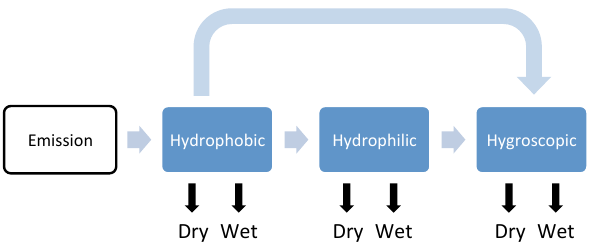
Fig. 1. Diagram showing the 3-ffBC/OM scheme. Hydrophobic, hy- drophilic and hygroscopic BM/OM then enter into the ice nucle- ation scheme in mixed-phase clouds as shown in Fig. 2.